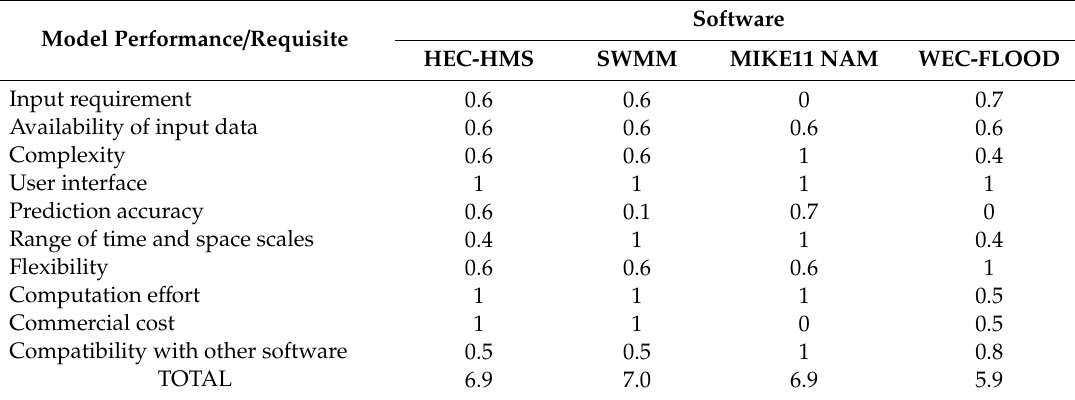
Table 5. Scores for the 10 parameters used for calculating the model evaluation matrix of the four hydrological computer models implemented in the Mesima torrent (Calabria, Southern